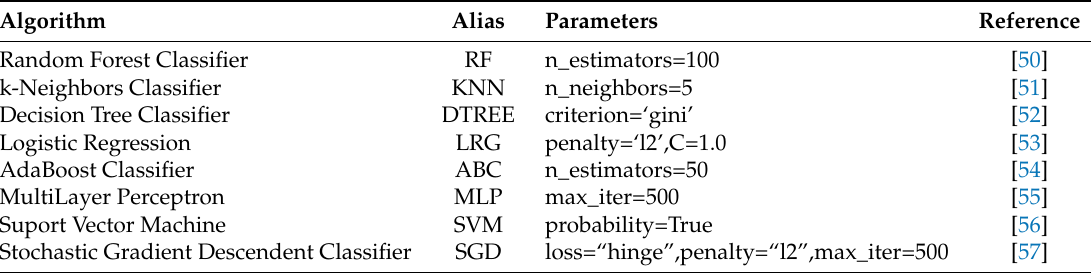
Table 3. Machine learning